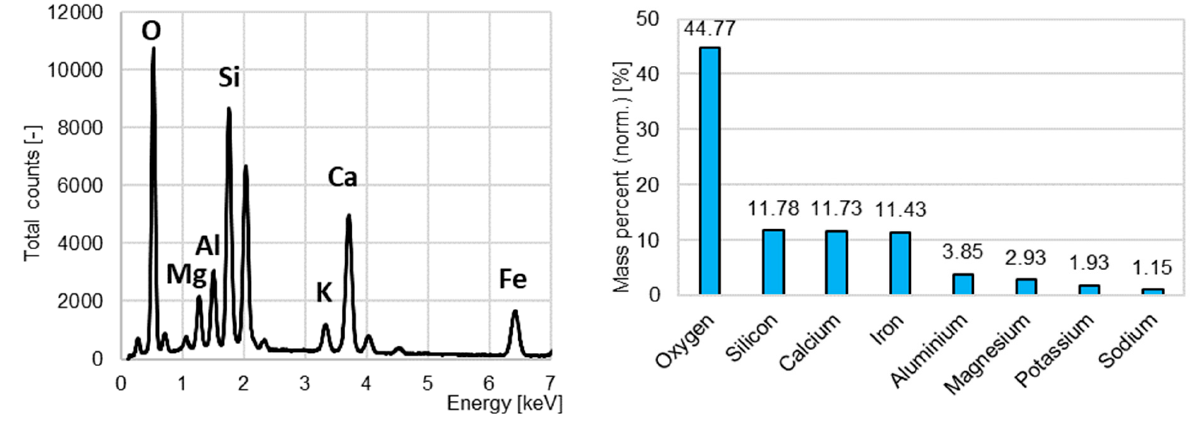
Figure 6. The energy-dispersive X-ray spectroscopy results for the burnt sewage sludge aggregate.